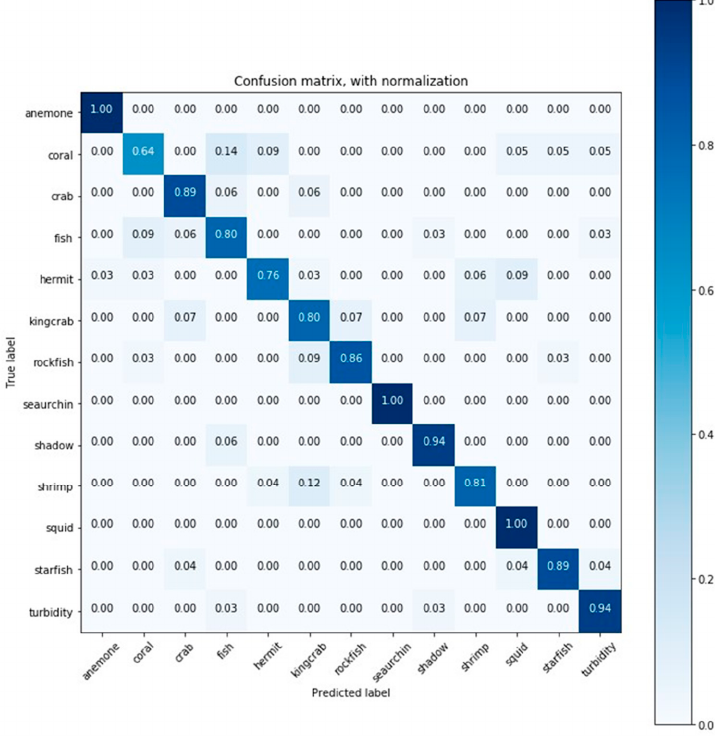
Figure 6. Confusion matrix for the classification results (accuracy) obtained by deep neural network (DNN) DNN-1.